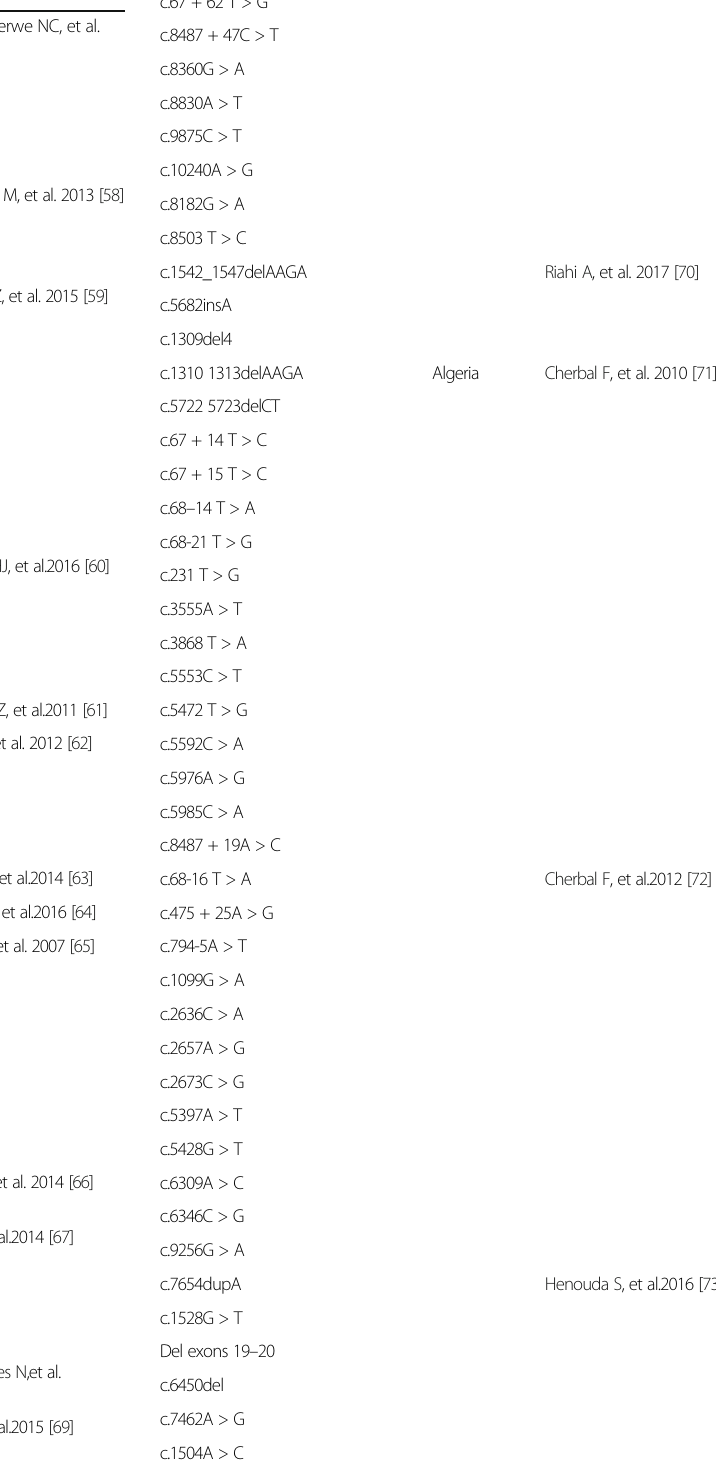
Table 7 Most of the BRCA2 mutations variants detected within African literature